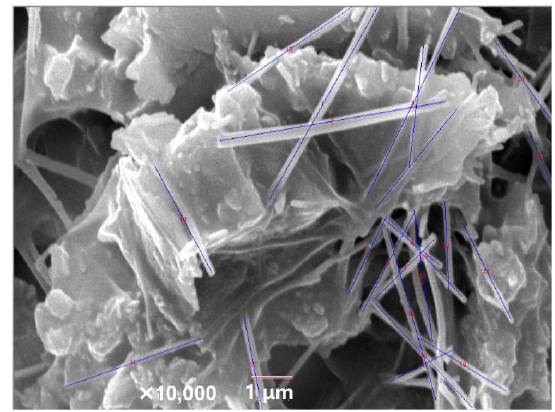
Figure 2. Nano Measurer statistical analysis for CRME (G1 mixture).